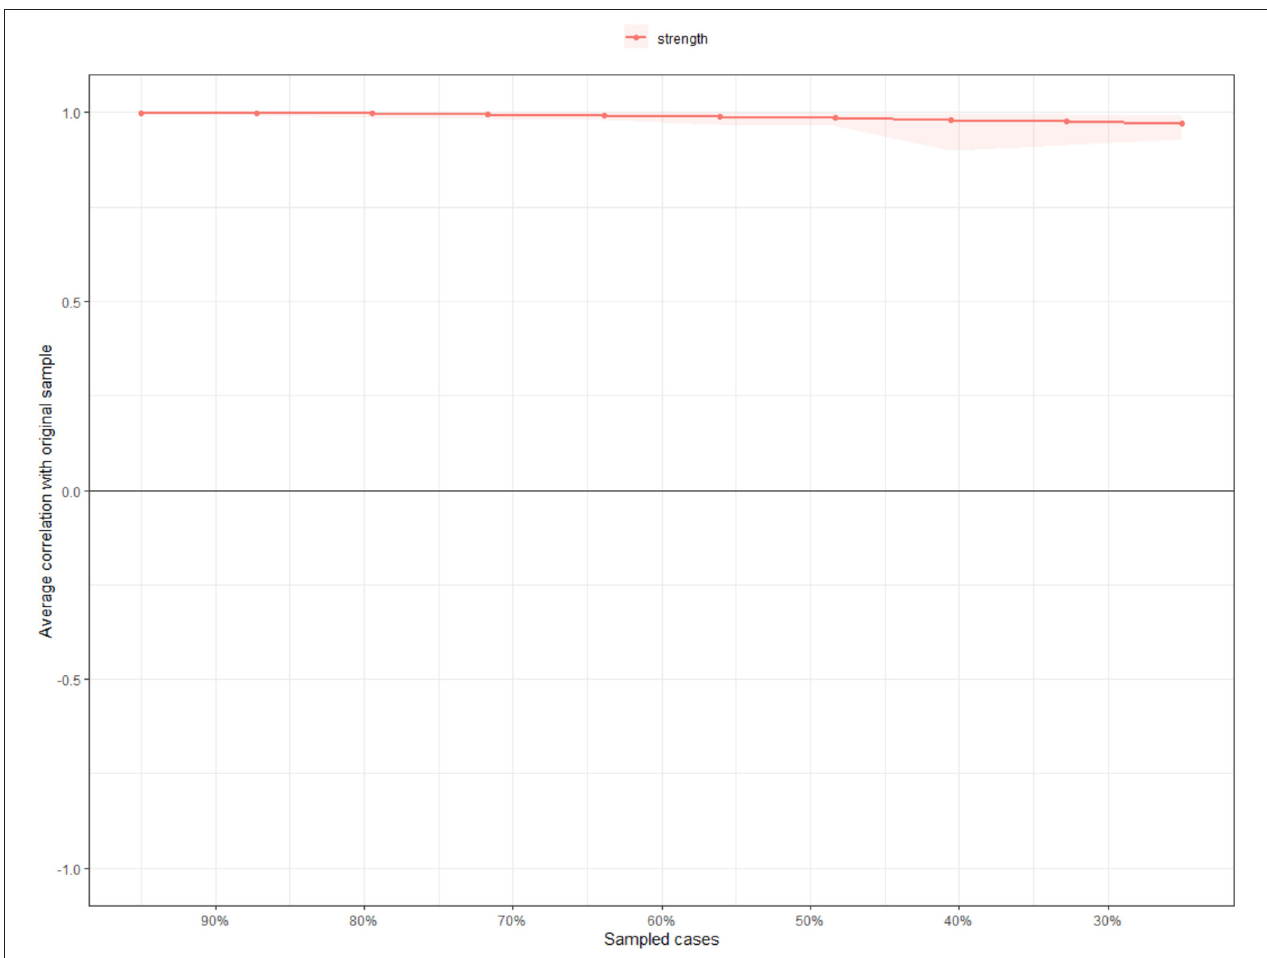
FIGURE 4 | Stability of network structure by case dropping subset bootstrap. The X-axis represents the percentage of cases of original sample used at each step. The Y-axis represents the average of correlations between the centrality indices from the original network and the centrality indices from the networks that were re-estimated after dropping increasing percentages of cases. Colored areas indicate 95% confidence interval.